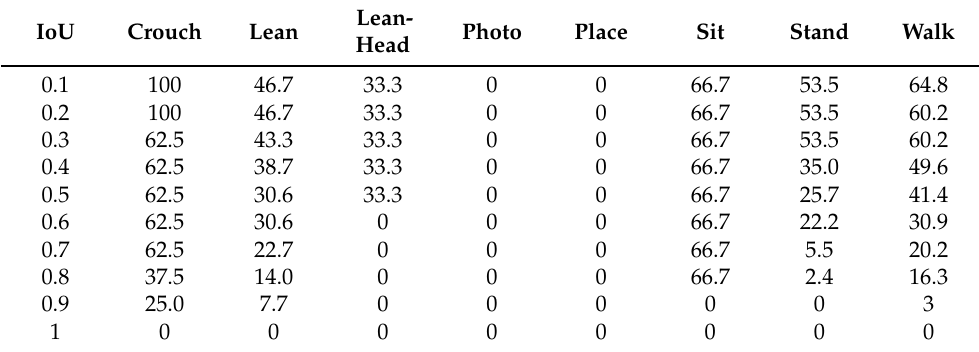
Figure 10. Examples of recognition results on the CCTV testing clips: in ( a ) a pedestrian with “LeanHead” action has been recognised, similarly in ( b ) “Crouch”, in ( c ) “Walk”, and ( d ) is a multiple- pedestrians scene with both “Stand” and “Walk” actions been recognised. Table 8. Class-wise temporal action detection results on the test dataset with mAP at different IoU thresholds α